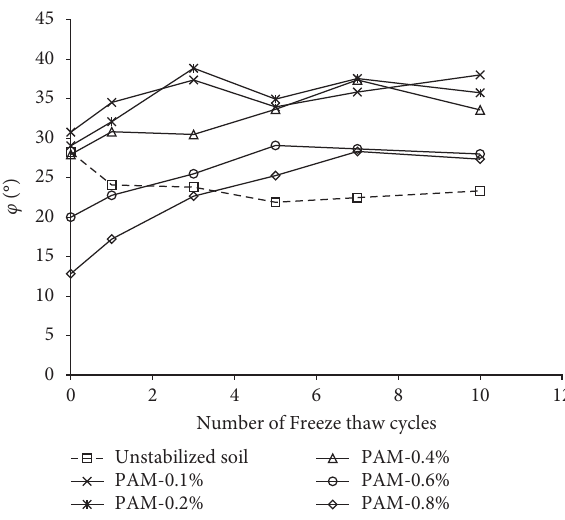
Figure 12: Changes of internal friction angle of PAM-stabilized samples with freeze-thaw